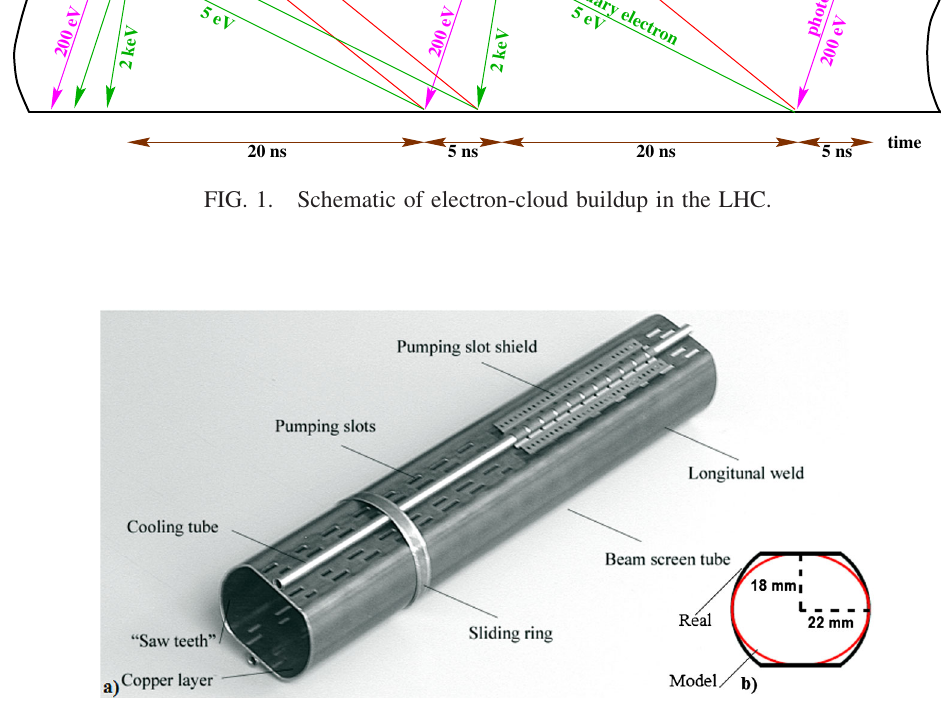
FIG. 2. (a) Picture of beam screen, showing the flattened round shape with two cooling tubes, pumping slots, and pumping slot shields (image courtesy of CERN); (b) in the simulations the beam screen is approximated by an elliptical